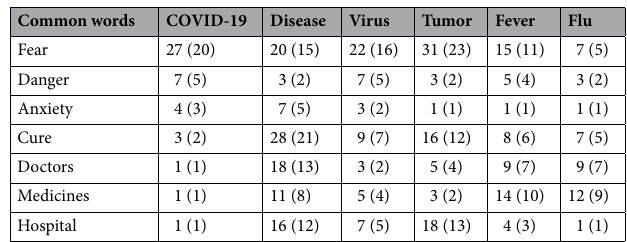
Table 3. Words in common among the six target concepts and percentage of participants producing the word for each concept. Raw frequencies are given in